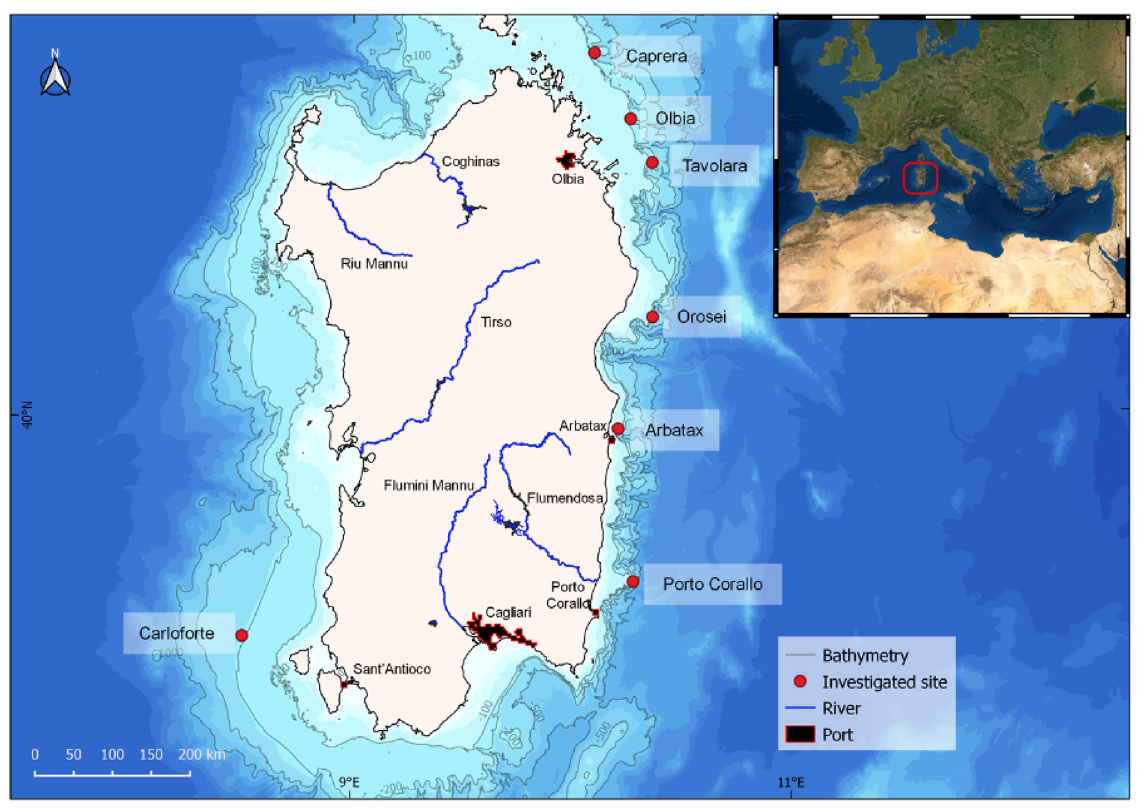
Figure 1. Map and isobaths of the Sardinian continental margin (West-Central Mediterranean Sea) with location of the study areas, main drainage network on land, and main Sardinian ports.